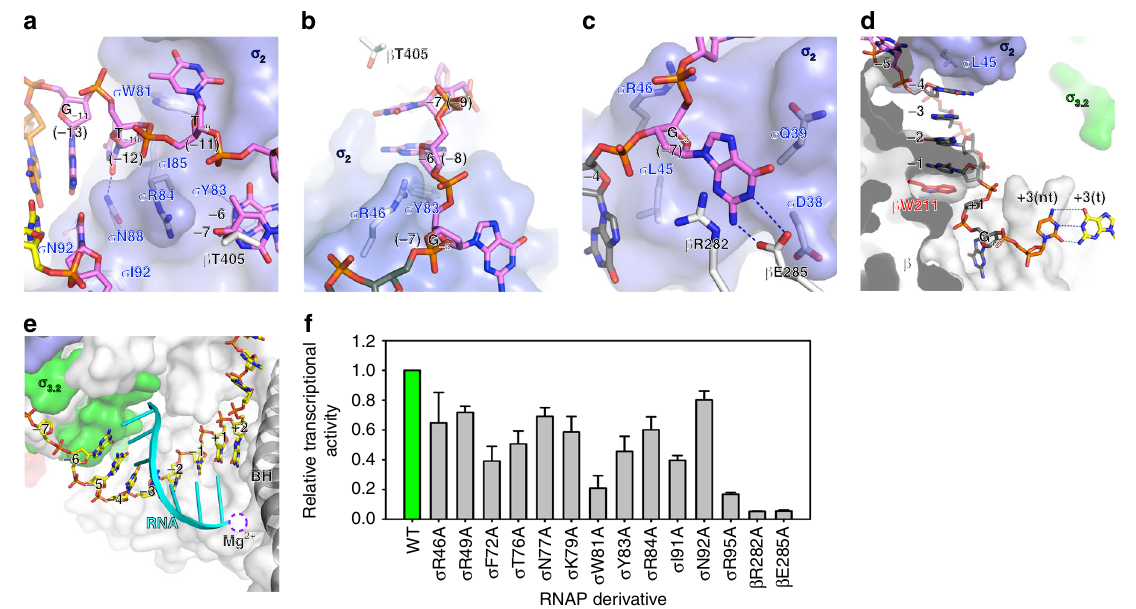
Fig. 5 The interaction between transcription bubble and RNAP in the Mtb σ H -RPo structure. a Recognition of the “ G − 11 T − 10 T − 9 ” sequence in the − 10 element by σ H 2 . b Stacking of − 7(nt) and − 6(nt) nucleotides by RNAP- β subunit and σ H 2 . c The recognition of G − 5 (nt) by RNAP- β subunit and σ H 2 . d The interaction between RNA polymerase (RNAP) and CRE element. Colors are as above. e The interaction between RNAP and DNA/RNA hybrid. f The in vitro transcription activity of RNAP derivatives comprising alanine substitutions of DNA-contacting residues on RNAP- β subunit and σ H . The experiments were repeated in triplicate, and the data are presented as mean ± S.E.M. Source data of f are provided as a Source Data fi